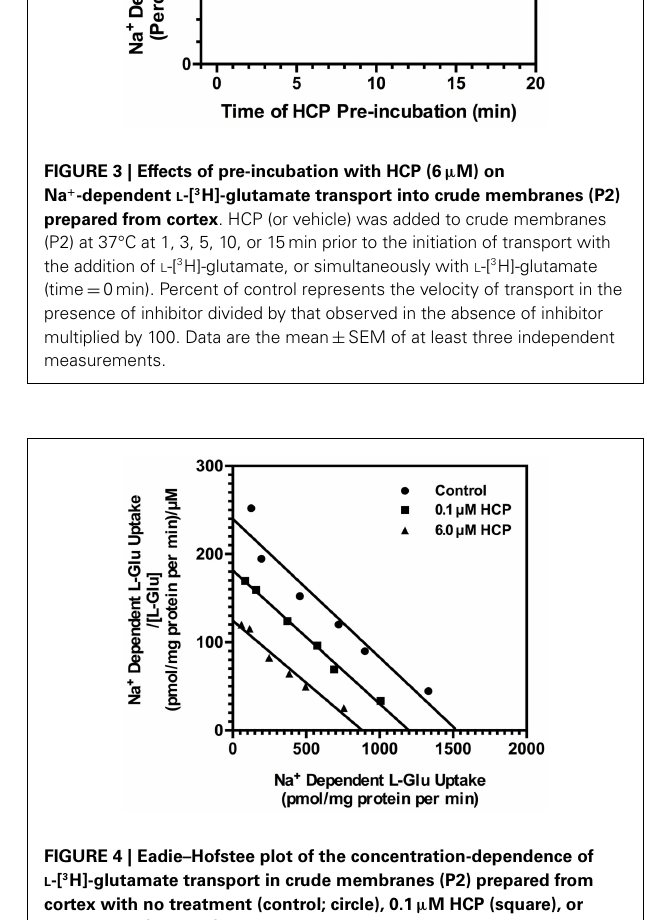
all three GDH inhibitors reduced Na + -dependent [ 3 H]-GABA transportincorticalmembranes(P2; Figure5C ).However,incon- trast tothe lackof inhibition observedwith l -[ 3 H]-Glu or d -[ 3 H]- Asp, all three compounds also inhibited [ 3 H]-GABA transport in crude cerebellar membranes (P2).